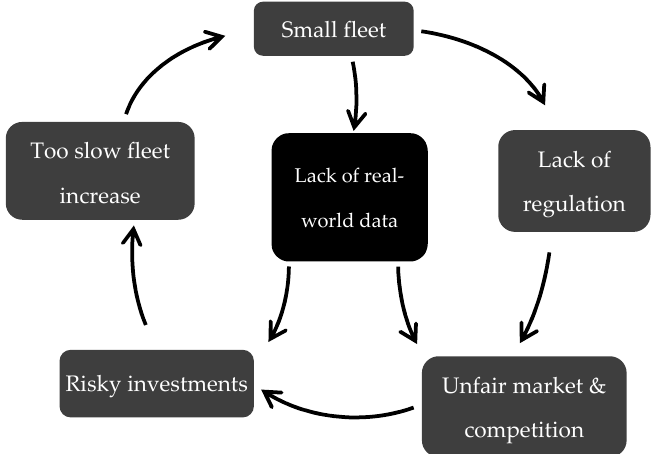
Figure 8. Illustration of the vicious circle in domestic battery